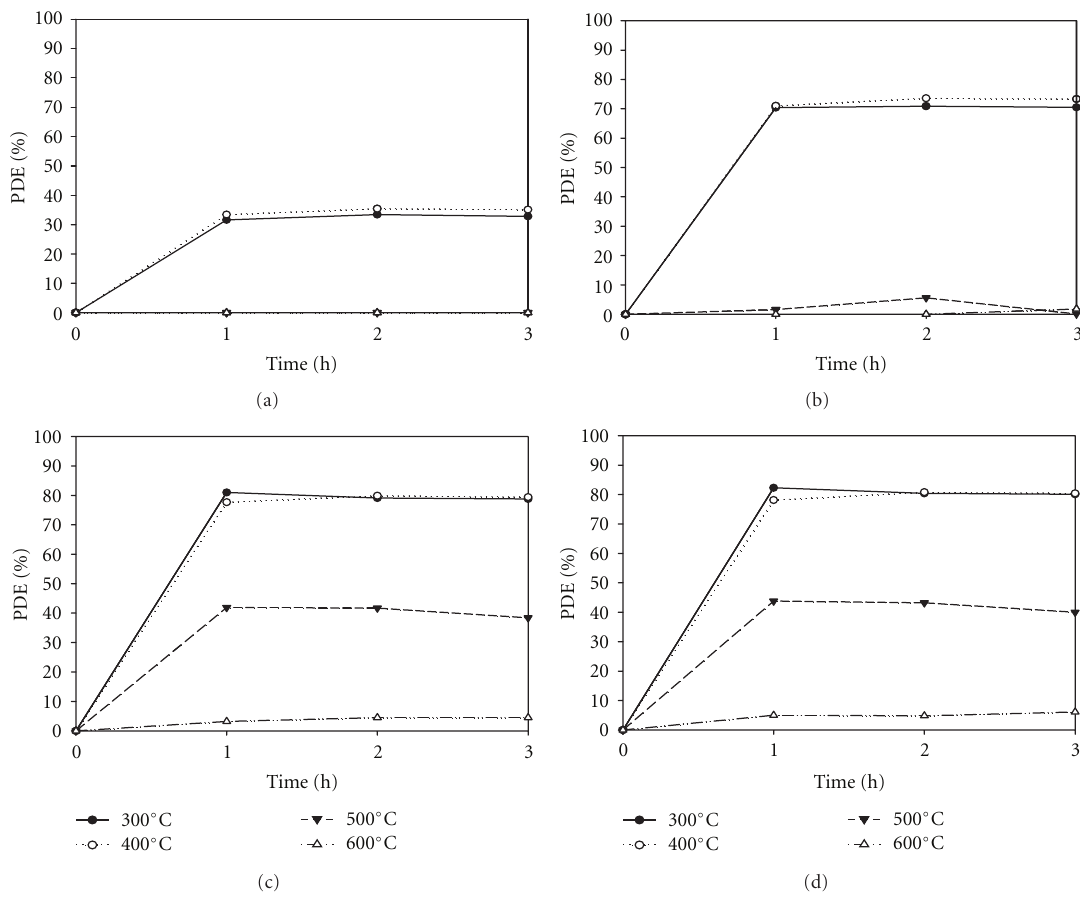
Figure 8: Time-series photocatalytic decomposition e ffi ciencies (PDEs) determined via MWNT-TiO 2 according to the calcination temperatures: benzene (a), toluene (b), ethyl benzene (c), and o-xylene